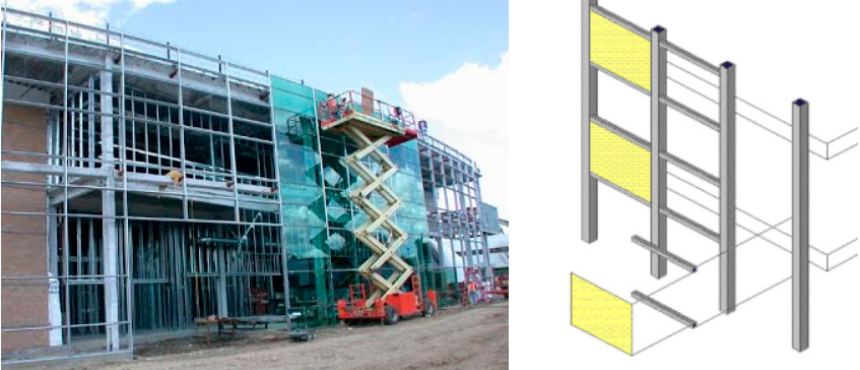
Figure 3. Stick Built Curtain Wall [12].